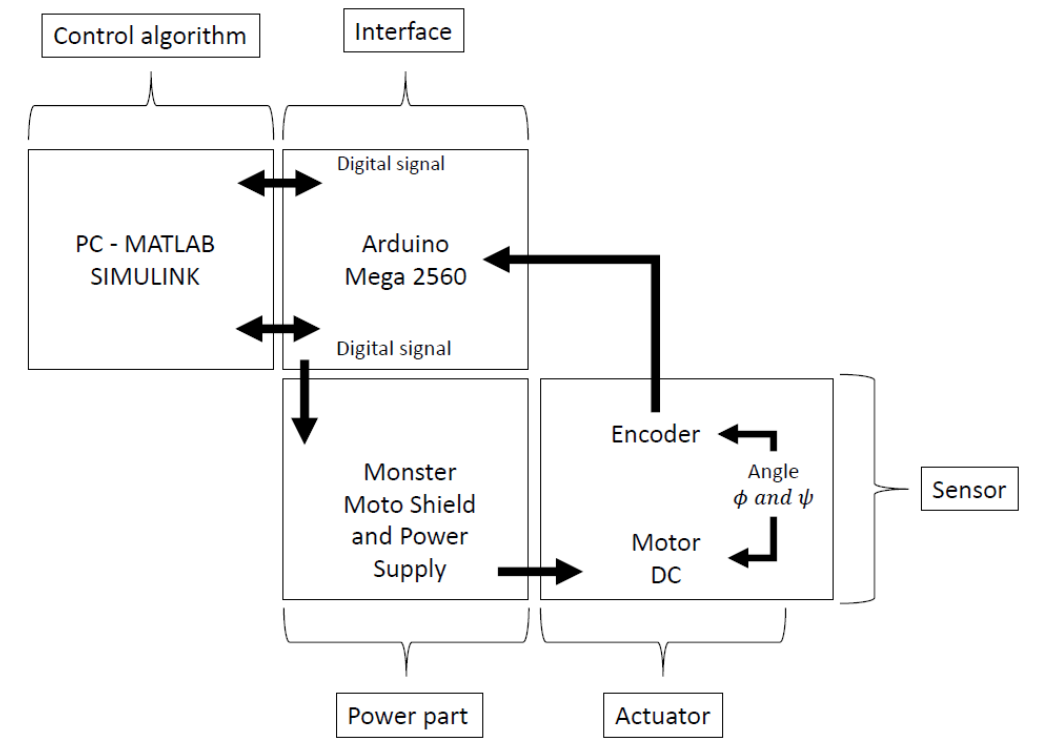
Figure 8. Schematic diagram of the 2-DOF helicopter closed-loop control system.